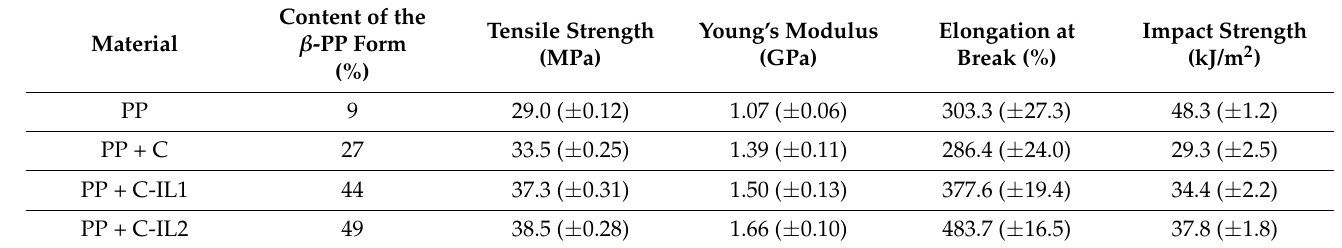
Table 2. The content of the β -PP form and strength properties for polypropylene matrix and tested